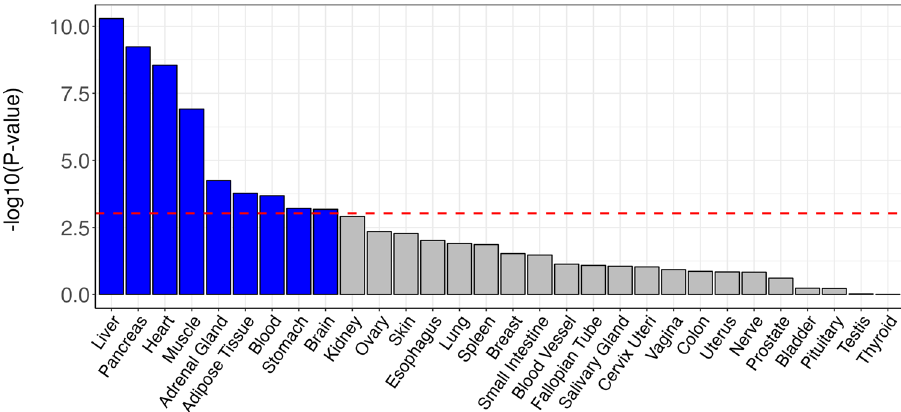
Fig. 3 Tissue-speci fi c differential expression of the set of signi fi cant genes identi fi ed through the multivariate GWAS on MRI-derived measures of body composition. The red-dotted line indicates the multiple comparisons-corrected signi fi cance 1173 genome-wide signi fi cant loci with α = 5 × 10 − 8 (list